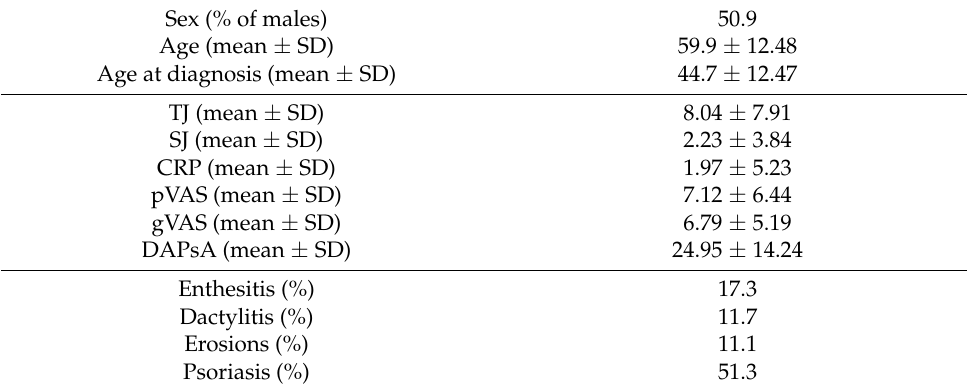
Table 1. Clinical data of the 160 PsA